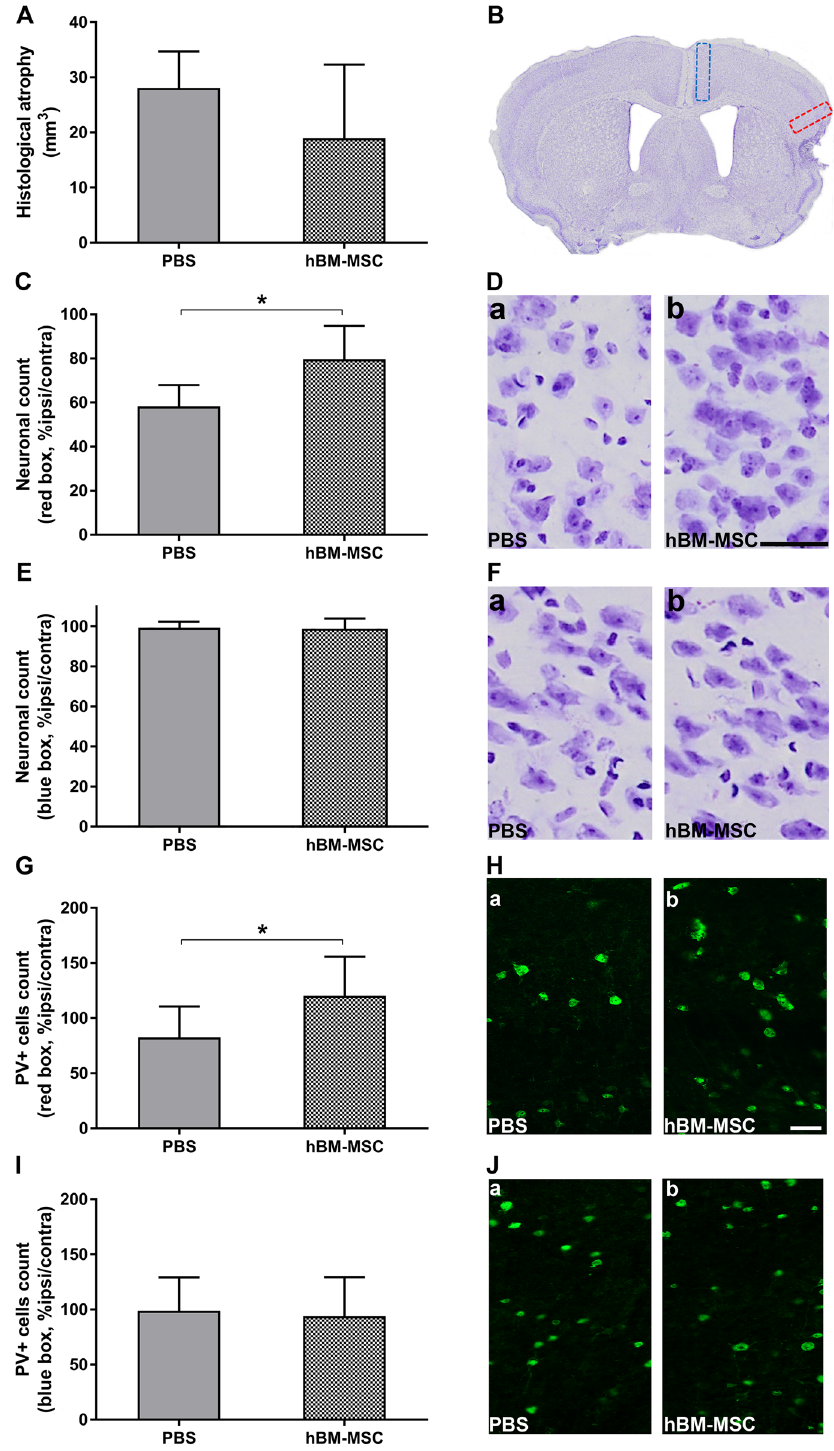
Figure 4. hBM-MSC promote neuronal survival in the perilesional area. ( A ) Stroke induces a similar atrophy in tMCAo hBM-MSC and tMCAo PBS mice 5w post-injury. ( B ) Representative micrograph shows typical brain atrophy and displays the ROI selected for histopathological analyses. Quantification of neuronal death in perilesional cortex (red box) indicates a neuronal rescue after hBM-MSC administration in stroke mice compared to tMCAo PBS mice ( C , D ). No difference is observed when a medial ROI (blue box) is selected ( E , F ). ( G ) Immunofluorescence analysis in perilesional cortex shows a higher percentage of PV + neurons in tMCAo hBM-MSC compared to tMCAo PBS mice. ( I ) The percentage of PV + cells in medial cortex is comparable in tMCAo hBM-MSC and tMCAo PBS mice. ( H , J ) Microphotographs show PV stained cells in red box (Ha,b) and in blue box (Ja,b). Data are mean + SD, n = 6–10, unpaired t-test. * p < 0.05. Bar = 50 µ